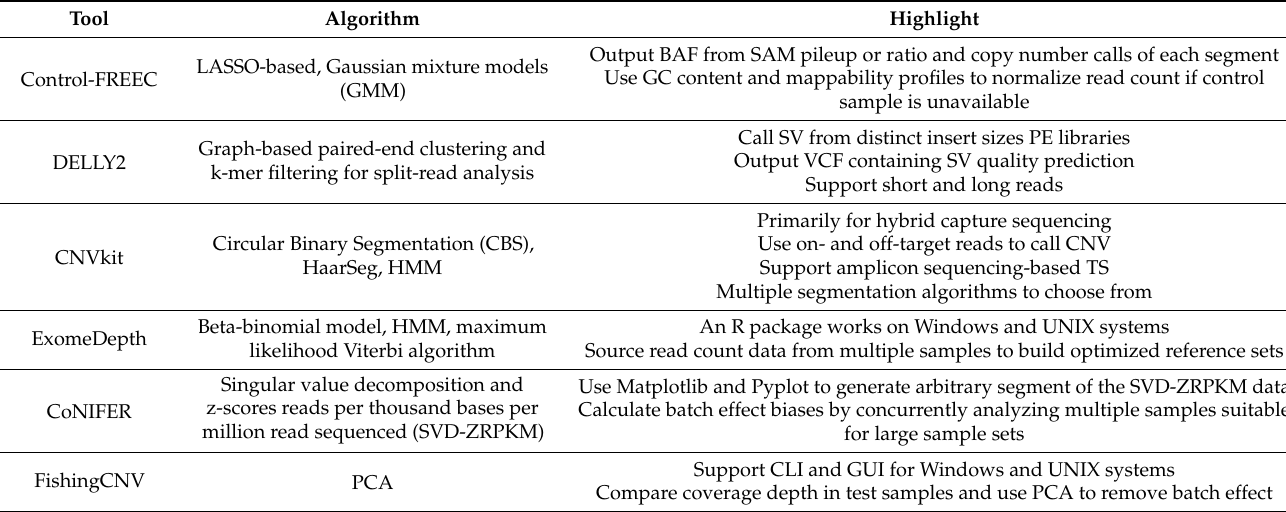
Table 1. CNV tools and their